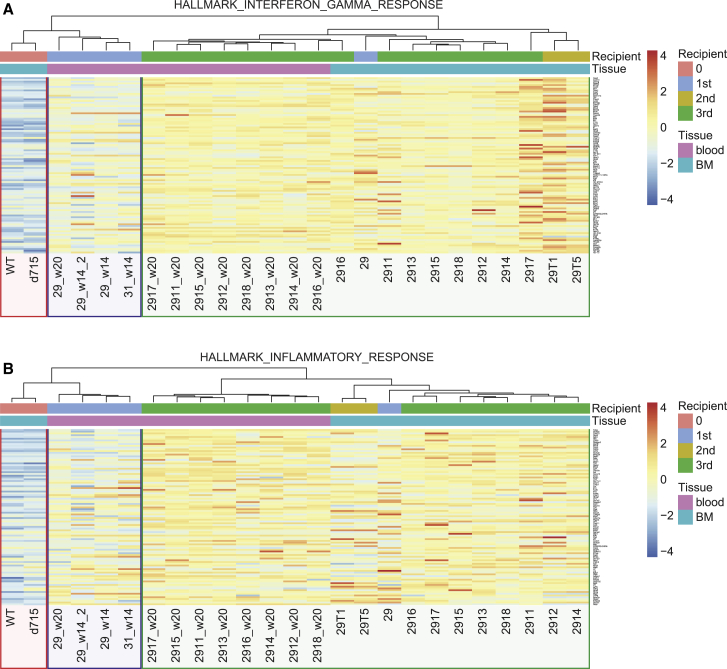
Elevated Inflammatory Transcriptomes Associated with Leukemic Progression in d715-RHD Mouse Models(A and B) Heatmap showing unsupervised clustering and expression of the top 100 differentially expressed transcripts in BM and PB samples of control, pre-leukemic, and leukemic LK/c-Kit+ cells (A) associated with IFN-γ signaling and (B) an inflammatory response.